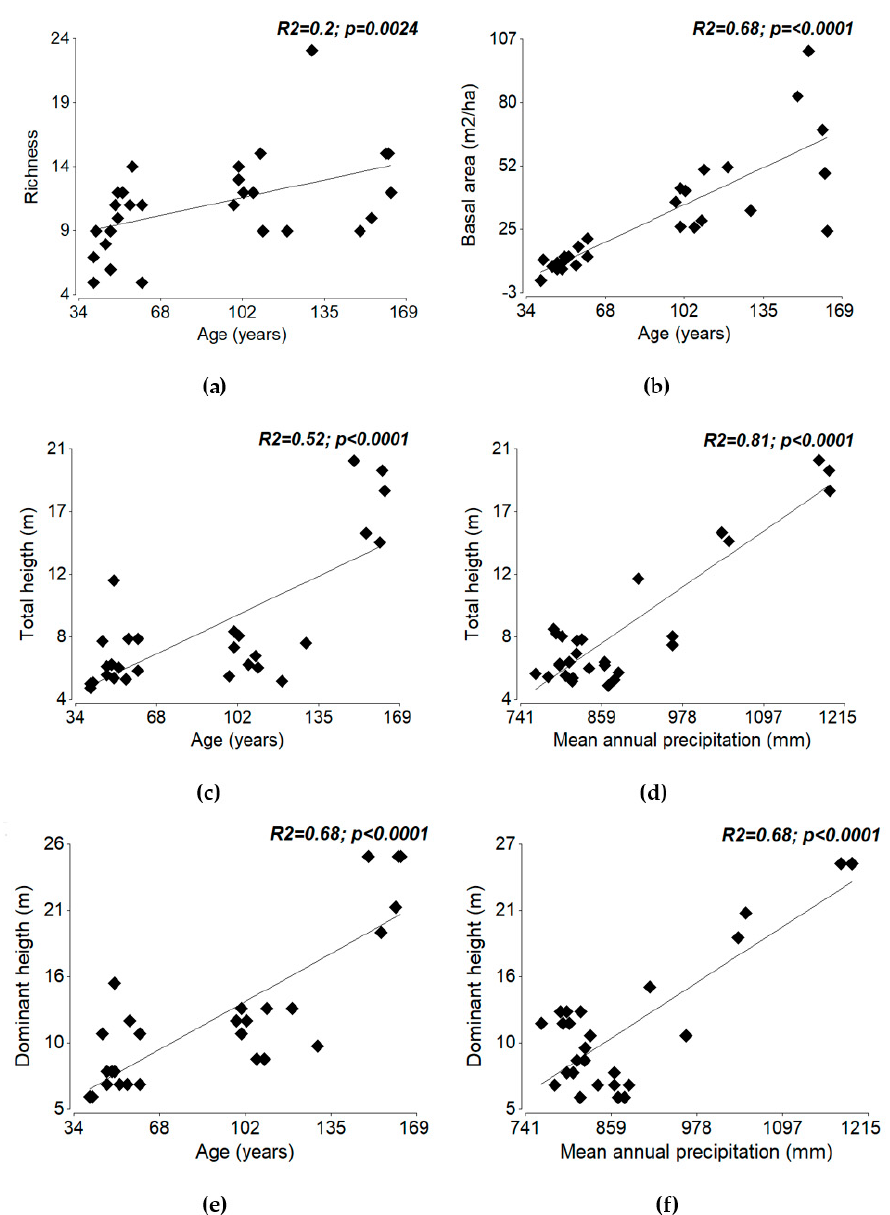
Figure 6. Linear regressions between response and predictor variables (selected with forward selec- tion). ( a ) age vs. species richness, ( b ) age vs. basal area, ( c ) age vs. total height, ( d ) mean annual precipitation vs. total height, ( e ) age vs. dominant height, and ( f ) mean annual precipitation vs. dominant height. R2 : adjusted regression coefficient.